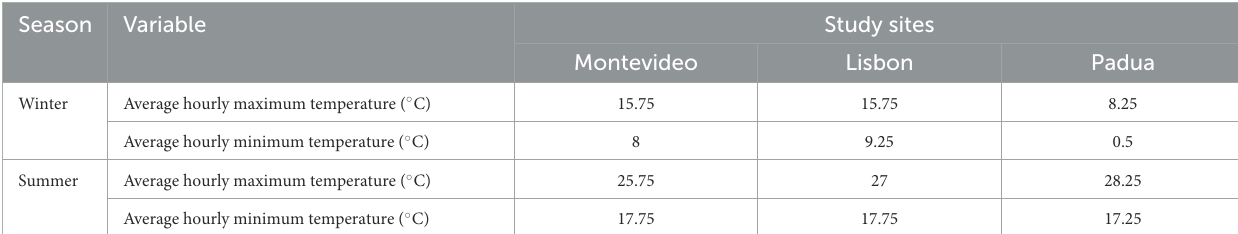
TABLE 1 Weather description of each study site, based on two variables (average hourly maximum temperature and average hourly minimum temperature) for winter and summer, according to Weather Spark